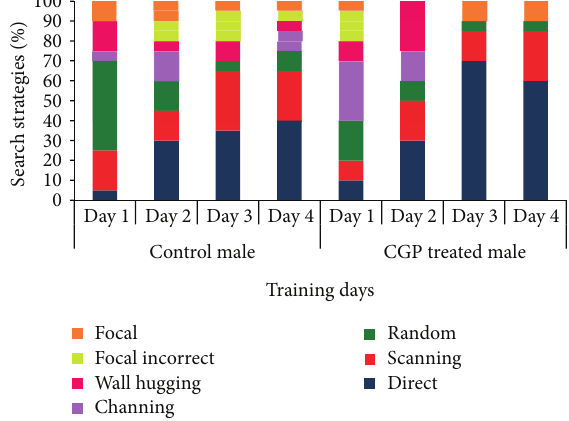
Figure 8: Swimming strategies of control and CGP 35348 treated male albino mouse during acquisition phase of Morris Water Maze